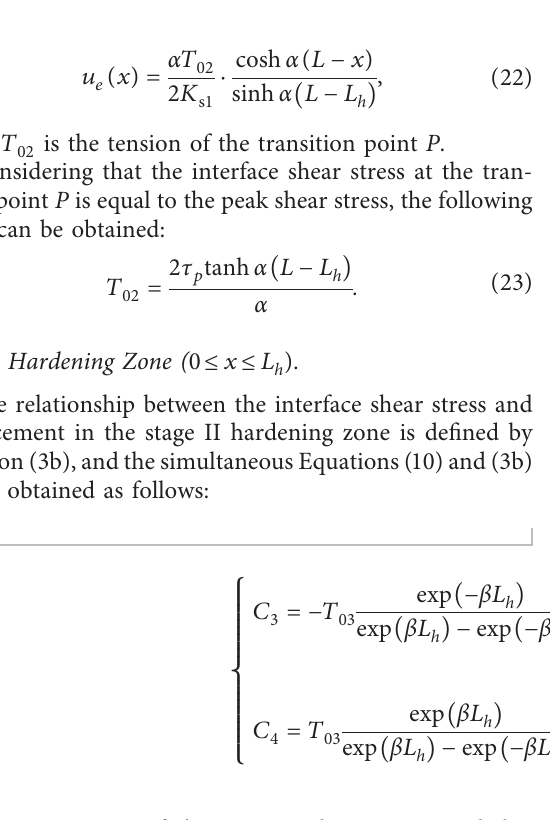
Figure 9: The progressive pull-out process of the strain-hardening reinforcement in the pull-out model analysis: (a) elastic stage; (b) elastic- hardening transition stage; (c) pure hardening